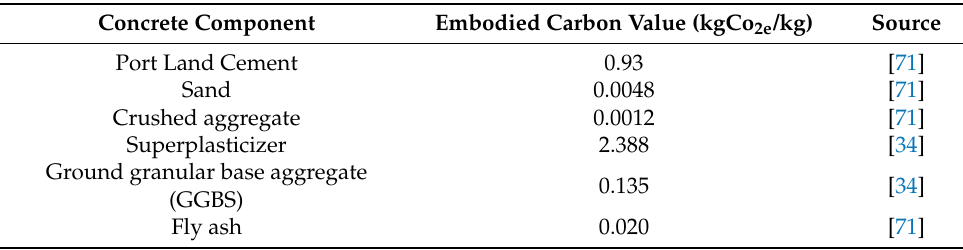
Table 7. Embodied Carbon for Concrete